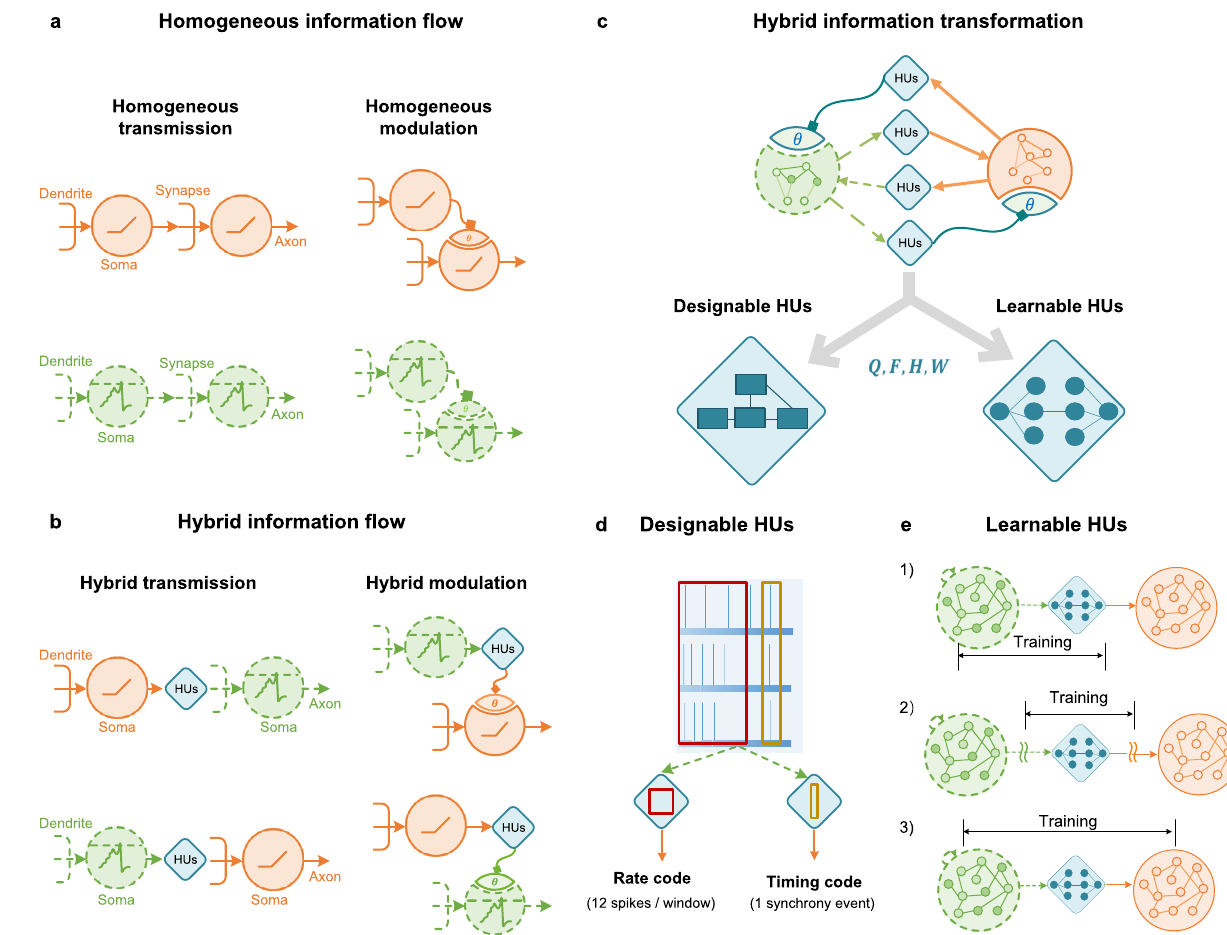
Fig. 1 Illustration of the proposed HNN framework. a Homogeneous information fl ow includes synchronous-continuous signals (solid orange lines) of ANN neurons (orange circle) and asynchronous-discrete signals (dashed green lines) of SNN neurons (green circle), respectively. Each case includes direct transmission (left, sharp arrow head) and indirect modulation (right, square arrow head pointing to parameters θ of modulated neurons). b Hybrid information fl ow is transformed by HUs (blue squares). c HUs have several basic computation steps, including truncating (W(t)), fi ltering (H(t)), non- linearity (F), and discretization (Q). These operations can be achieved by knowledge-driven manual design or data-driven automatic learning. d Designable HUs are con fi gured according to the target coding schemes by prior knowledge and prede fi ned mapping (The long time-scale red window for rate coding, short time-scale yellow window for timing code (e.g., synchrony)). e Learnable HUs can be con fi gured in three learning ways: (1) jointly training with frontend/backend networks, (2) independent training, and (3) training with complete